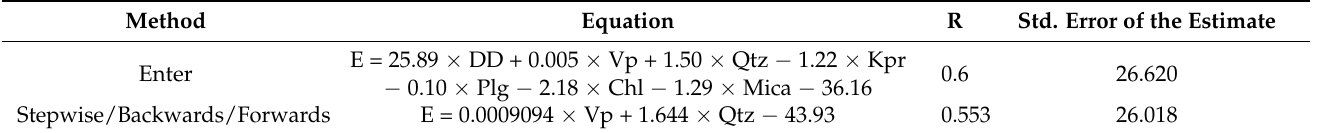
Table 2. Equations using various multiple regression